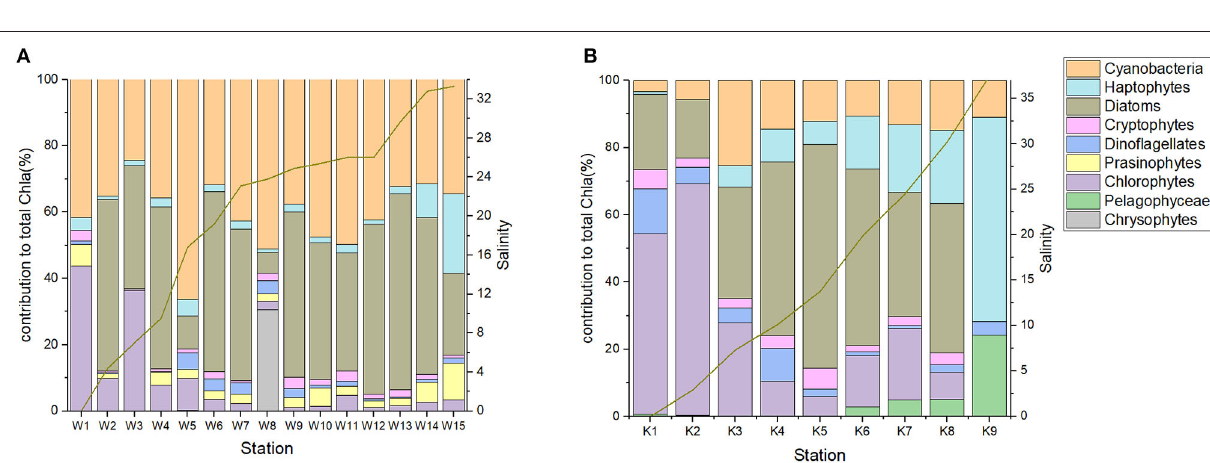
pronounced stratification and its role in inhibition of vertical mixing and diffusion of